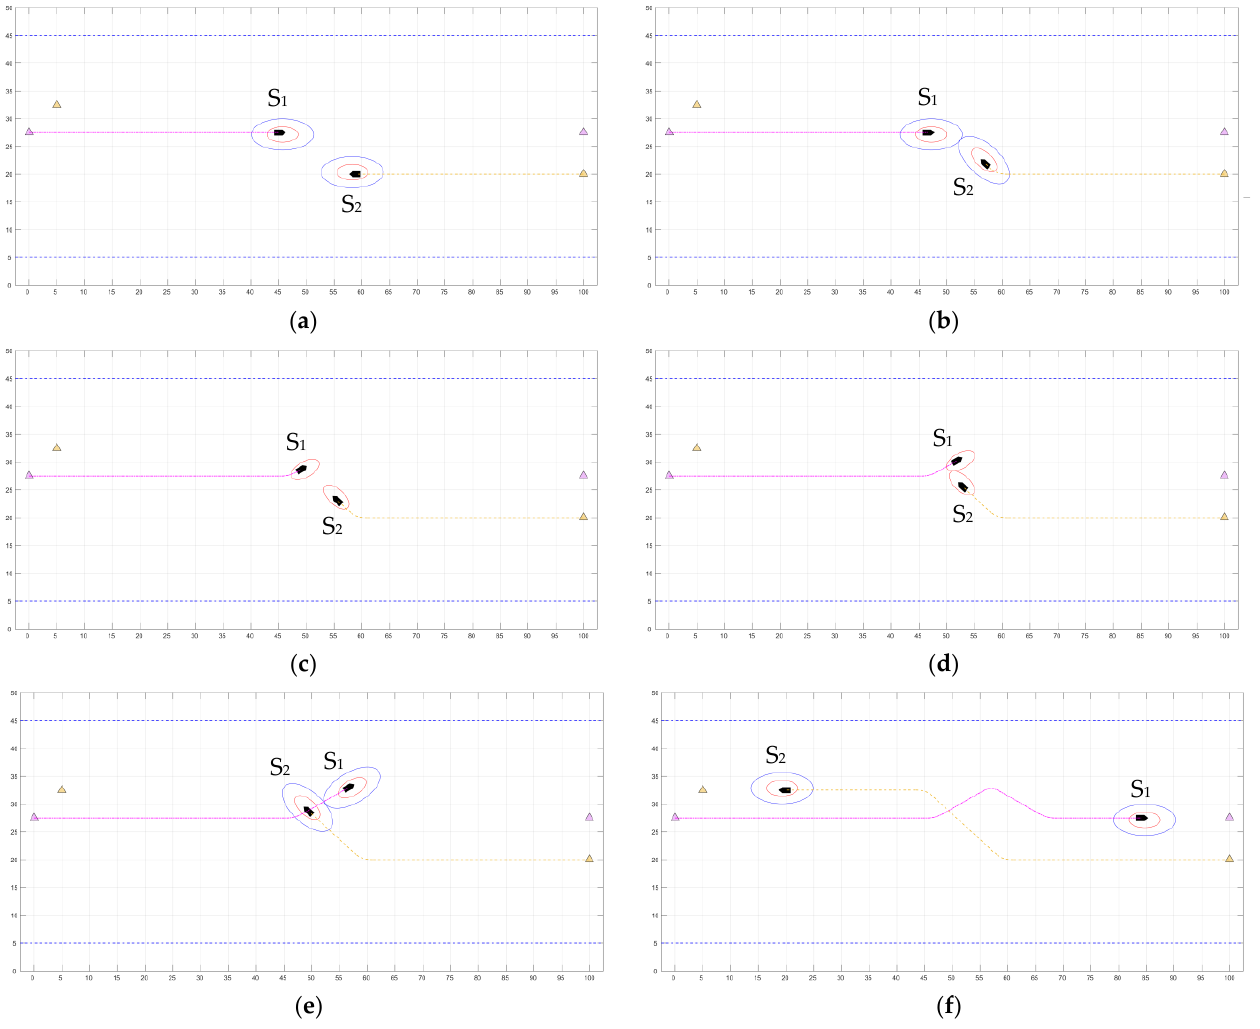
Figure 20. Collision avoidance in close-quarters situation: ( a ) scenario 1, ( b ) scenario 2, ( c ) scenario 3, ( d ) scenario 4, ( e ) scenario 5 and ( f ) scenario 6.